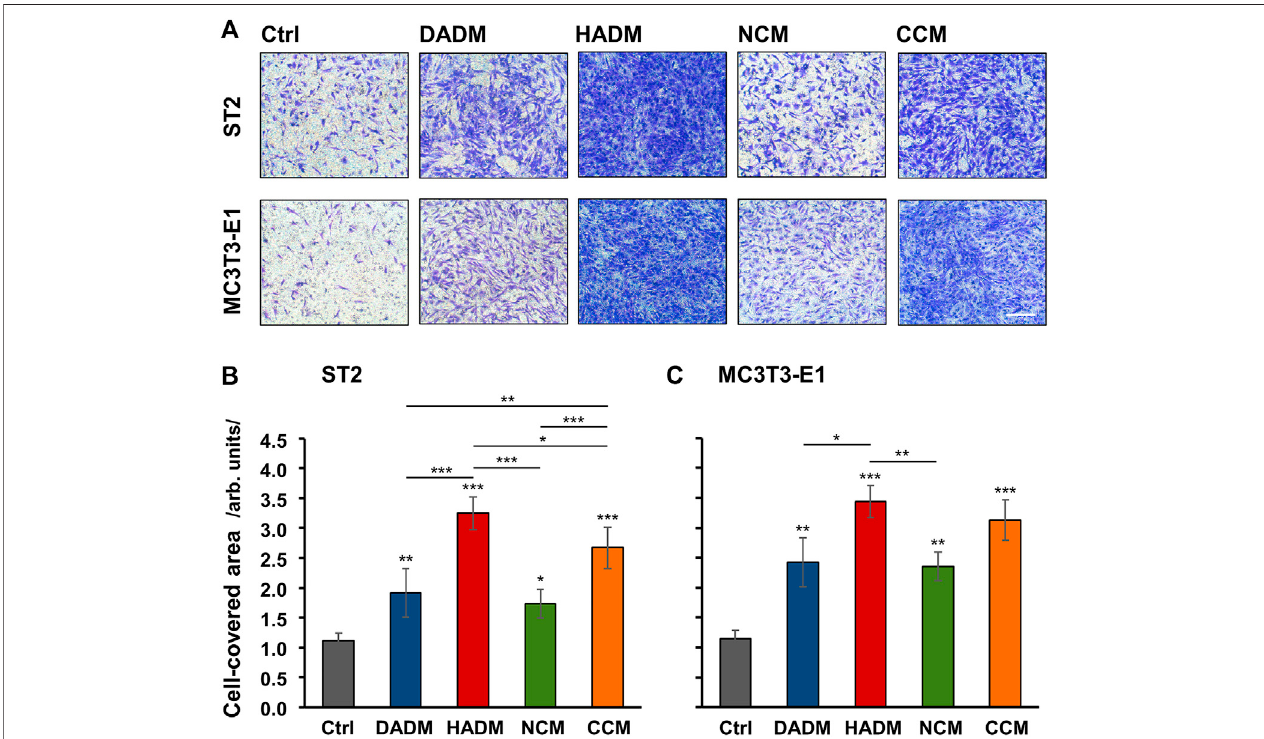
FIGURE1| Increasedmigratorypotentialofosteoprogenitorcelllinestowardfourdifferentcollagen-basedmatrices.MigrationofmesenchymalstromalST2 (A,B) and pre-osteoblastic MC3T3-E1 (A, C) cells toward DADM, HADM, NCM, and CCM matrices was evaluated by a modi fi ed Boyden chamber migration assay utilizing ThinCert ® transwell PET membrane supports with 8 μ m pore size. (A) Representative images of fi xed and stained cells that have migrated to the lower side of the membrane in each of the experimental groups. Scale bar, 500 μ m. (B, C) Quanti fi cation of the cell migration in the absence (Ctrl) or presence of collagen-based matrices by using the Image J software measuring the area on the lower side of the membrane support covered with migrated cells. Data represent means ± SD from three independentexperimentsperformedwitheachofthetwocelllines.Signi fi cantdifferences totherespectivecontrolsunlessotherwiseindicated,*** p < 0.001,** p < 0.01, * p <